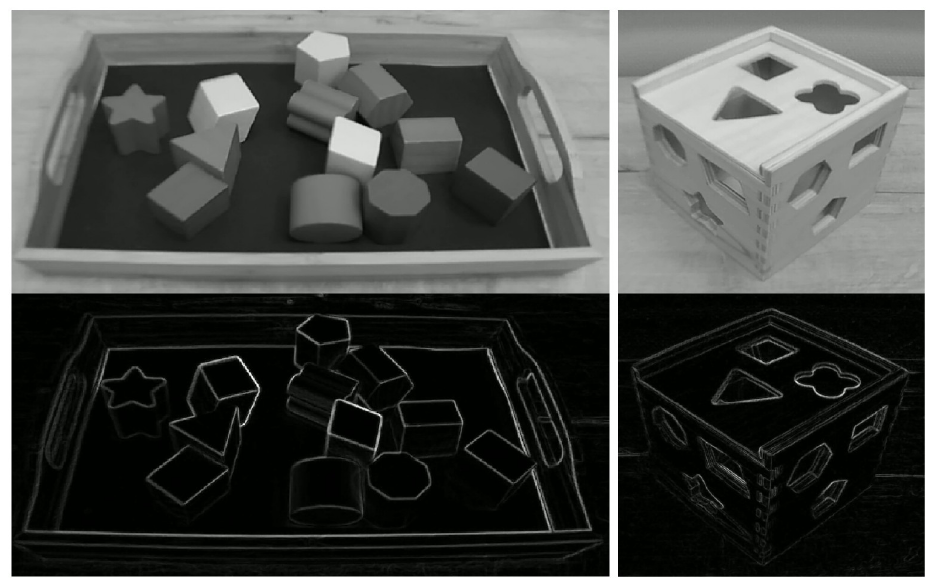
Fig 4. Gray-scale images and contour-drawings of 12 prism-shaped objects on a tray (left) and the box with 12 holes (right) used in Experiment 1. The shapes of the holes corresponded to the 12 individual objects. https://doi.org/10.1371/journal.pone.0242581.g004 trial numbers in each block (1, 2, and 3). The effect of the trial numbers ( F = 9.0, p = 2,50 0.00046 × 7, where 7 is multiplied for a Bonferroni correction, see [53]) and the interaction between the filters and groups ( F = 27, p = 3.5 × 10 − 6 × 7) were significant. The results 1,50 of the other effects were not significant: the filters ( F = 0.31, p = 0.58 × 7), the groups 1,50 ( F = 0.016, p = 0.97 × 7), the trial numbers × filters ( F = 0.22, p = 0.80 × 7), the trial 1,10 2,50